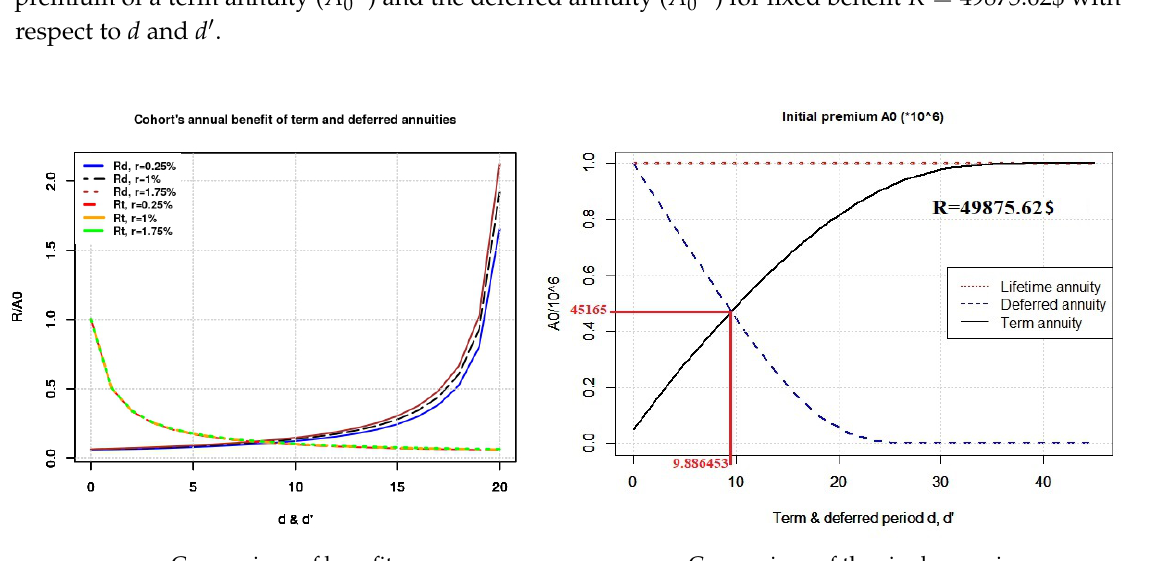
Figure 1. Annual benefits for equal premiums and premiums for equal annual